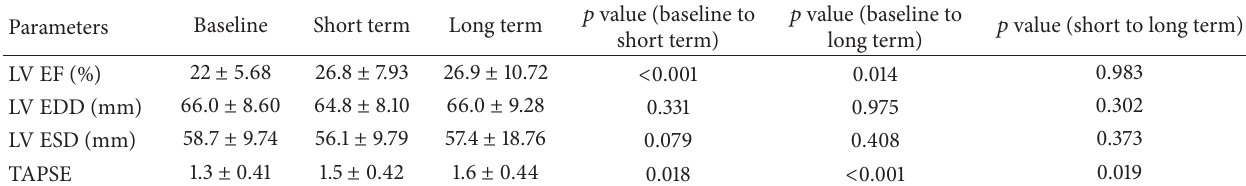
Table 2: Echocardiography parameters.